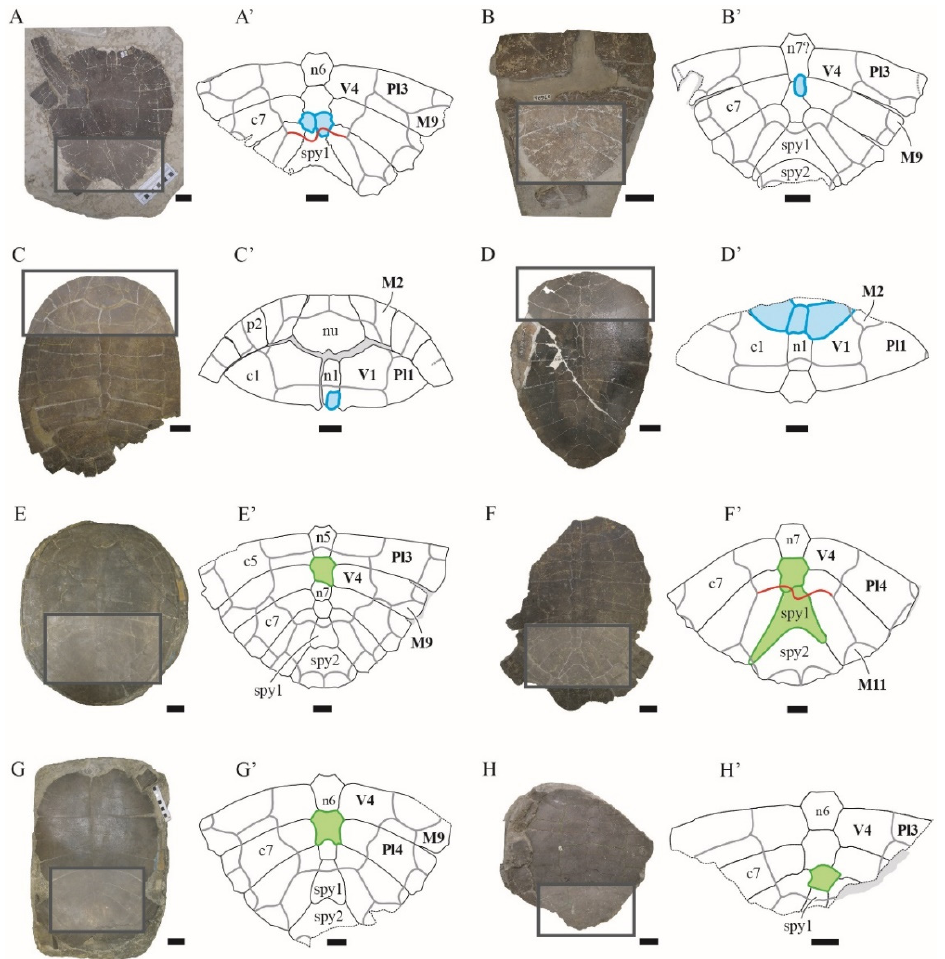
Figure 1. Anomalous carapaces of Pleurosternon bullockii (Paracryptodira, Pleurosternidae), from the Berriasian (Early Cretaceous) of Swanage (Dorset, UK). All of them are in dorsal view. ( A , A’ ) OUMNH K54009, ( B , B’ ) NHMUK OR 40960, ( C , C’ ) NHMUK OR 43621, ( D , D’ ) YPM VPPU 3364, ( E , E’ ) CAMSM J5327, ( F , F’ ) NHMUK OR 47401, ( G , G’ ) CAMSM